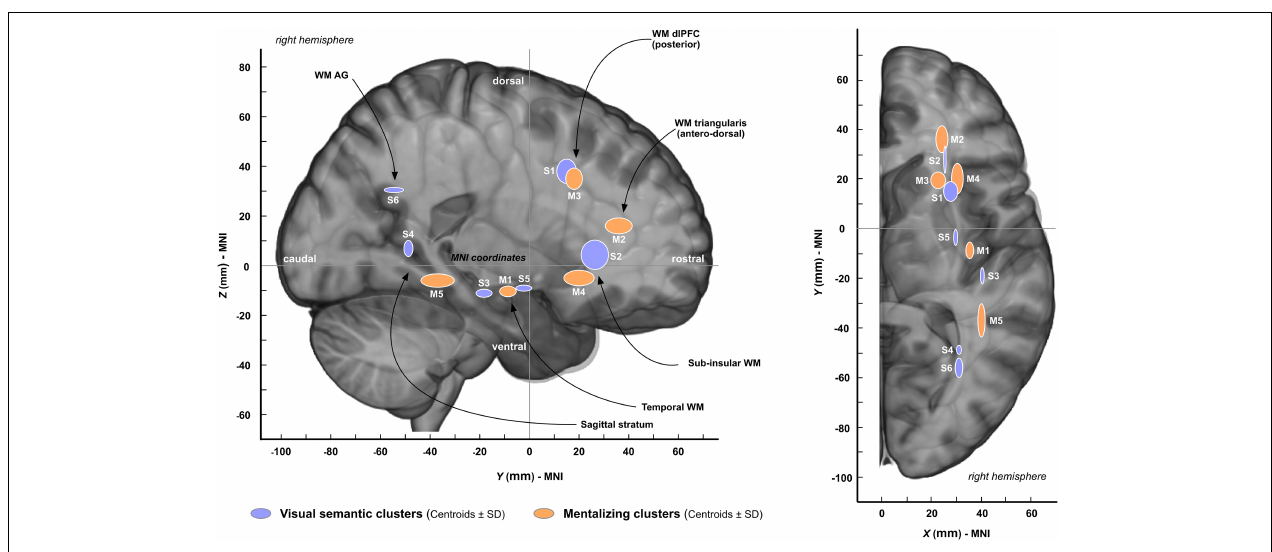
FIGURE 4 | Results from the clustering analysis. The coordinates of each cluster are represented by centroids ± SD (see Table 2 for the precise MNI coordinates). “S” means “semantic cluster” and “M” means “mentalizing cluster.” AG, angular gyrus; dlPFC, dorsolateral prefrontal